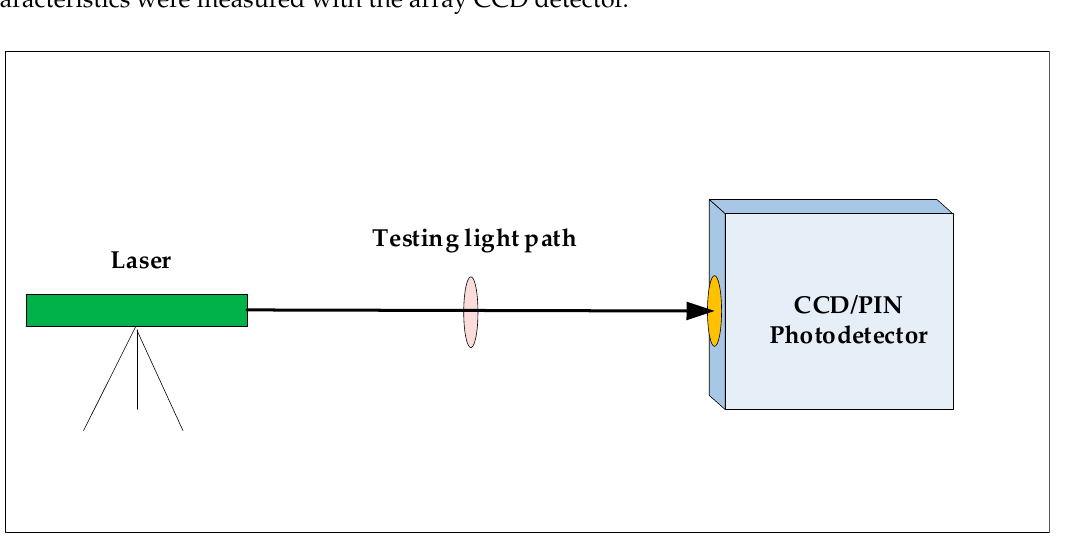
Figure 4. Laboratory test of laser emission pulse.